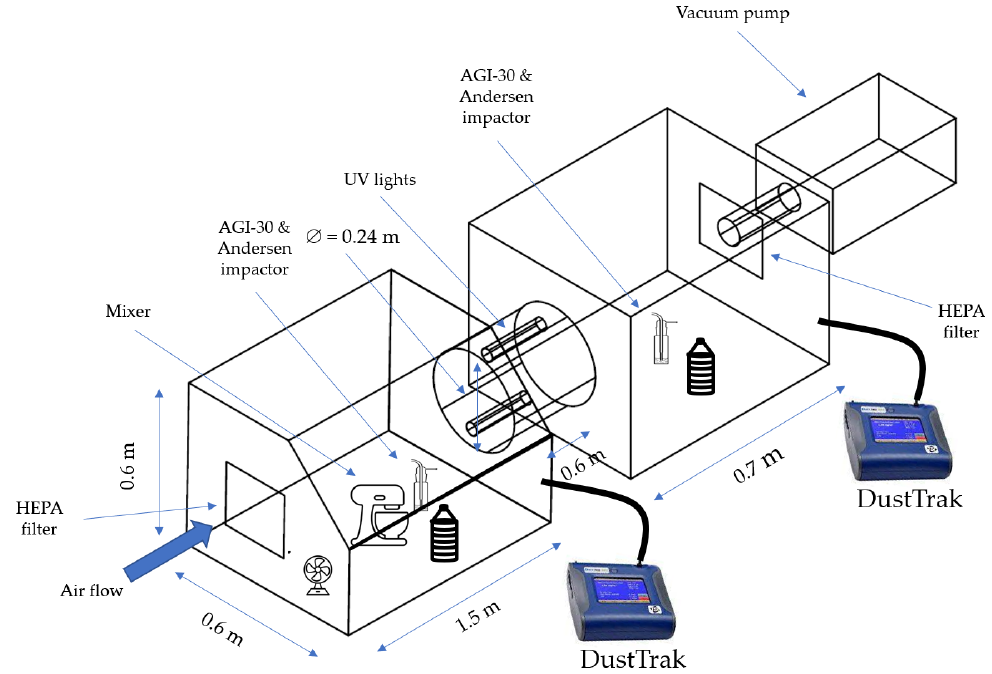
Figure 2. Testing system designed for examining the inactivation efficiency of UV light on airborne E. coli .